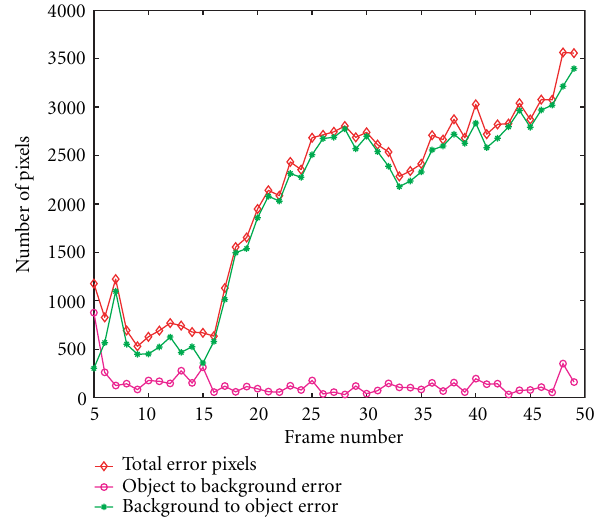
Figure 11: Plot of the segmentation errors, for COST AM 5.0.